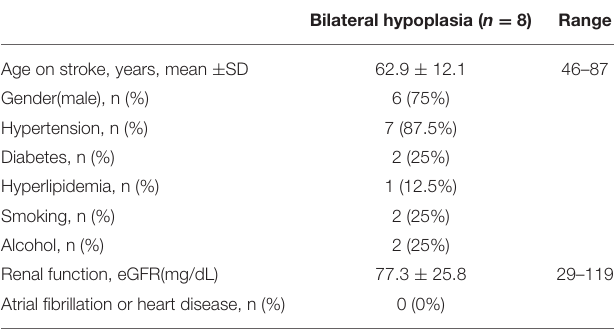
TABLE 1 | Demographic and clinical characteristics of eight patients with bilateral vertebral artery hypoplasia.